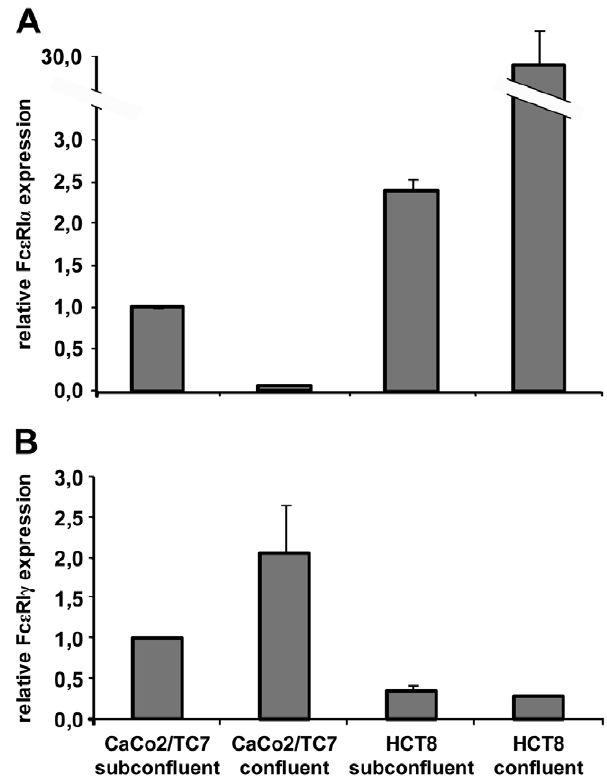
Figure 5. Expression of Fc e RI a - and c -chain but not b -chain mRNA in human intestinal epithelial cells. The expression pattern of the Fc e RI complex was analyzed by real-time PCR analysis using specific primers for detection of (A) Fc e RI a -, b - (not shown), and (B) c - chain. Target gene expression levels were normalized to the average of housekeeping genes and are depicted relative to the value of subconfluent Caco-2/TC7 cells. The values are presented as means + / 2 SD (n=3) from one experiment. The results are representative of two independent experiments.